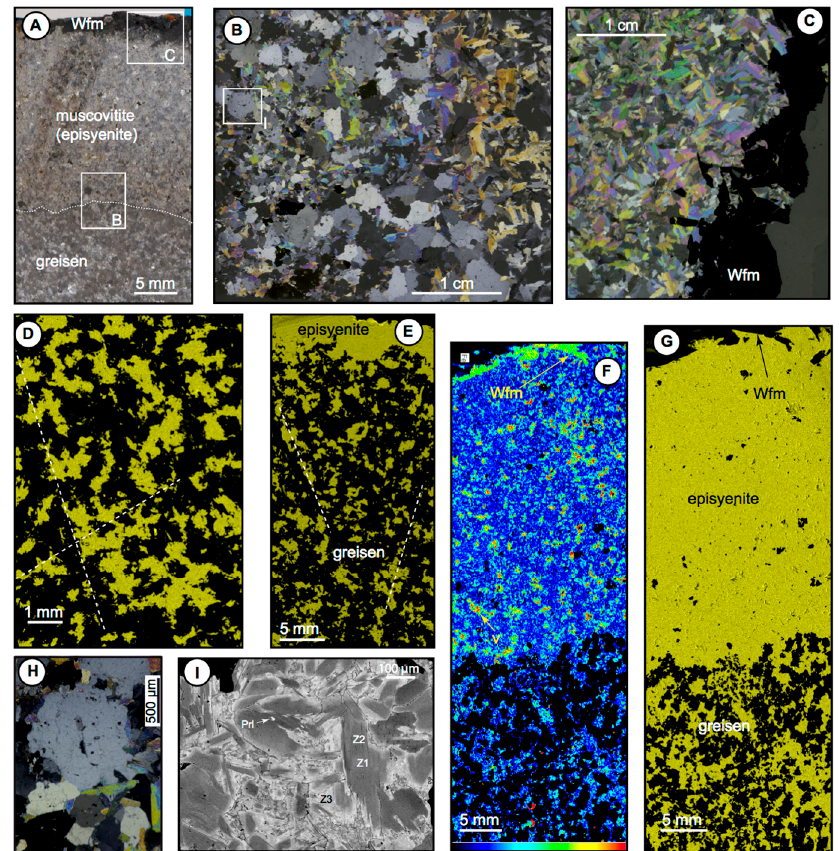
Figure 9. Muscovite and muscovite (“episyenite”) in the greisen cupola, at the L0 ( A – C , F – H , sample PAN-VI-17), and the L2 ( D , E , I ) levels. ( A ) Overview photograph of the sample, showing the joining of a muscovite-only rock on to a greisen. Note the wolframite (Wfm) fringe in the muscovite. ( B ) Overview photomicrograph of the greisen / muscovite contact (cross-polarized light). ( C ) Overview photomicrographs of the muscovite and the wolframite rim (cross-polarized light). ( D ) False-colored µ XRF map (K · K) of the greisen (sample PNQ-19), imaging the muscovite-quartz assemblage. Note the complicated, lace-shaped morphology of the muscovite flakes and the preferential elongation of the muscovite aggregates along with privileged directions (dotted lines). ( E ) False-colored µ XRF map (K · K) of a contact “greisen”-episyenite (sample PNQ-17a). Note the quite sharp “front of episyenitisation” and the apparent preferential orientations of the muscovite aggregates. ( F – G ) False-colored µ XRF maps of the greisen / episyenite contact in sample PAN-VI-17 from the L0 level. Note the intimate association between muscovite and wolframite crystals (wolframite pseudo-vein), and the development of micro-vugs in the episyenite body. ( F ) Fe · K map; whatever the location, “greisen” or episyenite, most of the muscovite displays the same iron content, i.e., there is no appearance of compositional zoning, although the Fe-rich fringes are more developed in the episyenite body. ( G ) K · K map; note the quite sharp “front of episyenitisation”. ( H ) Photomicrograph of relic magmatic quartz in the L0 greisen (sample PAN-VI-17). Note the embryonic snowball texture. ( I ) SEM-BSE image of compositional and patchy zoning in a muscovite aggregate (“greisenisation”) from the G1a granite (sample PAN16-4a). The crystals display a three-zoned texture, with a grey core (Z1), a darker first rim (Z2), and a bright second rim (Z3). Note the Z3 rims and the protolithionite (Prl) relicts in one muscovite core.